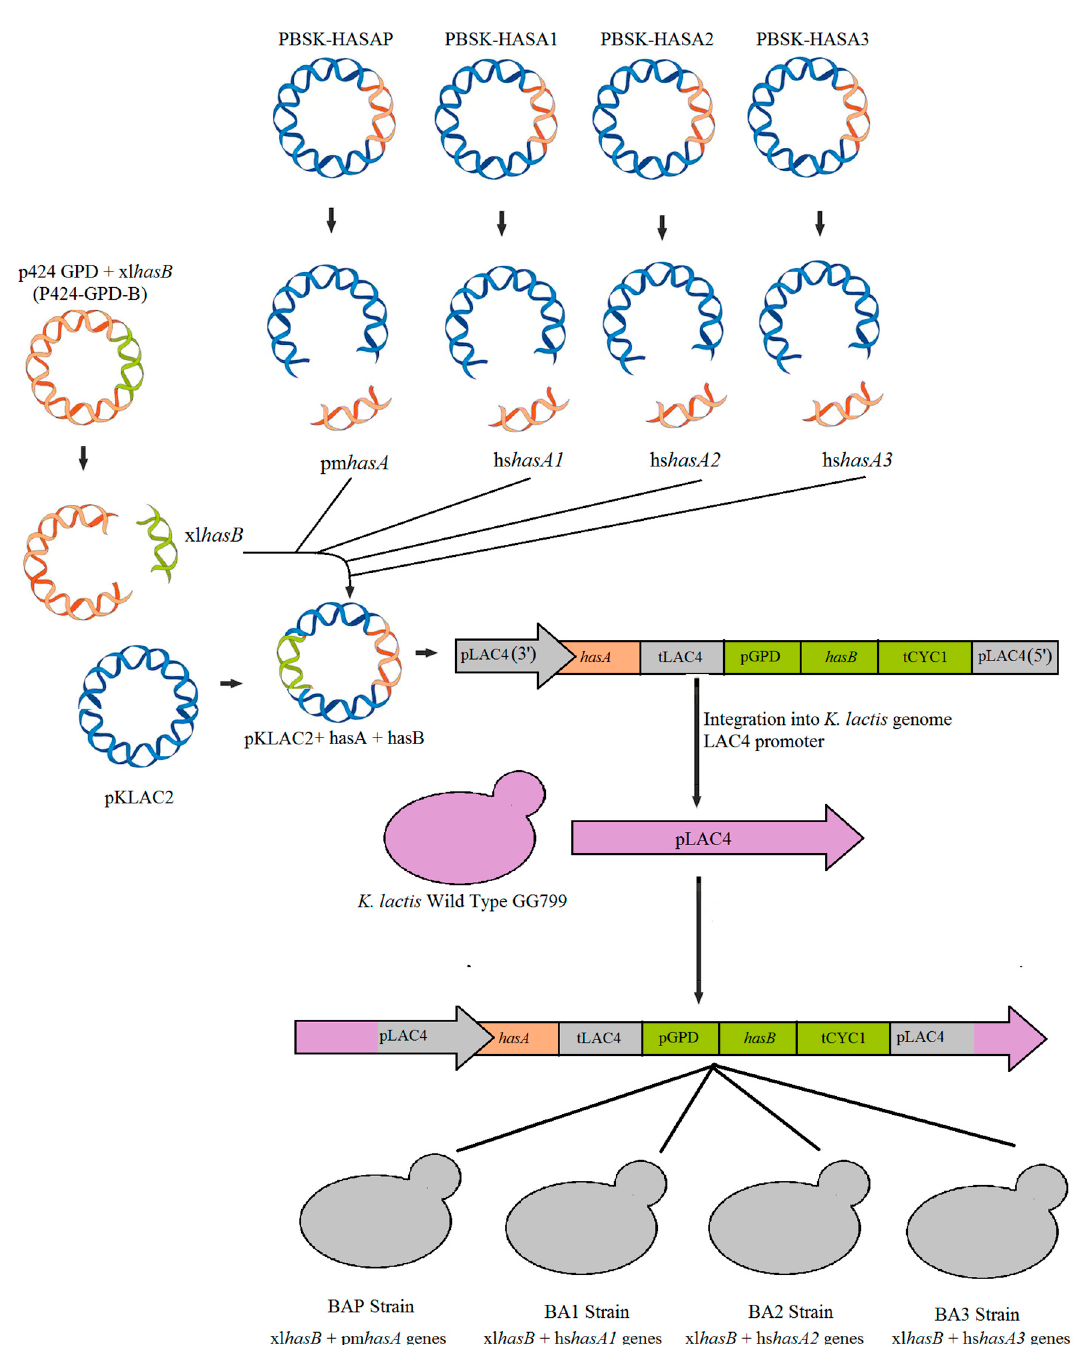
Figure 2. Overall construction strategy for the four strains generated in this study. The hasB gene from Xenopus laevis (xl hasB ) and the different versions of hasA genes from Homo sapiens (hs hasA1 , hs hasA2 , and hs hasA3 ) and Pasteurella multocida (pm hasA ) were inserted into the integrative plasmid pKlac2 for recombination in the LAC4 promoter of the K. lactis genome.